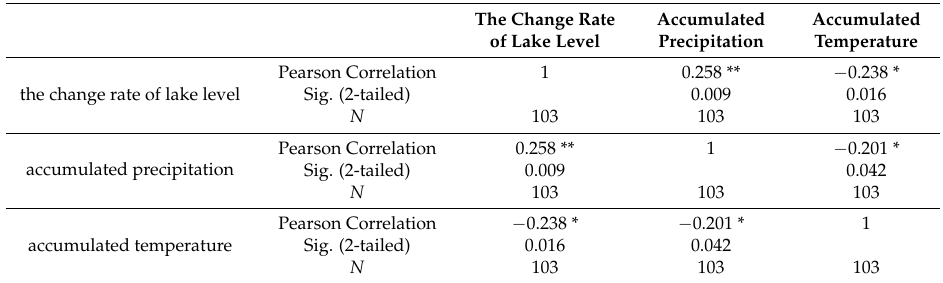
Table 1. The correlation of the change rate of the average lake level and the change rate of accumulated precipitation and accumulated temperature in the